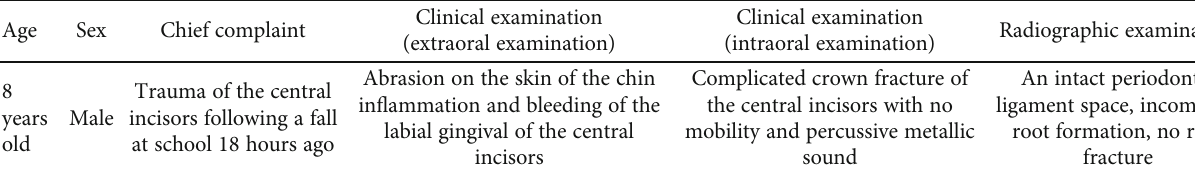
Table 1: Patient characteristics.